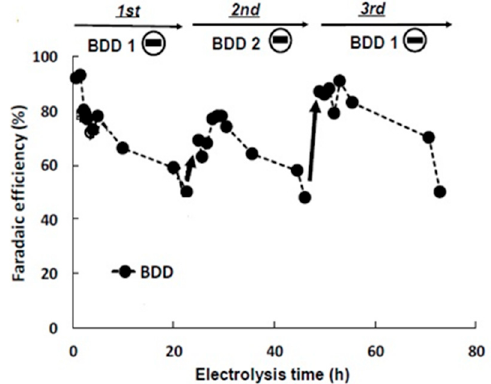
Figure 4. Long-term test on a double BDD cell. The faradaic efficiency changes upon alternating the polarity of the BDD electrodes, reproduced from [85], Copyright (2020), with permission from the American Chemical Society.